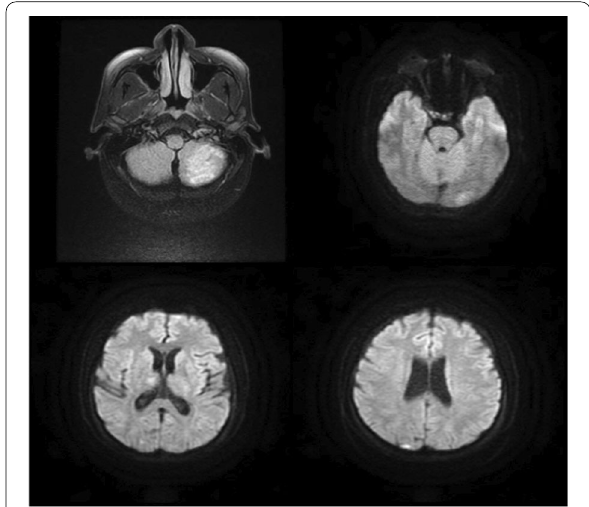
Fig. 2 MRI brain axial DWIs show left inferior cerebellar, left occipital, and right thalamic subacute infarcts and right occipital acute cortical infarct